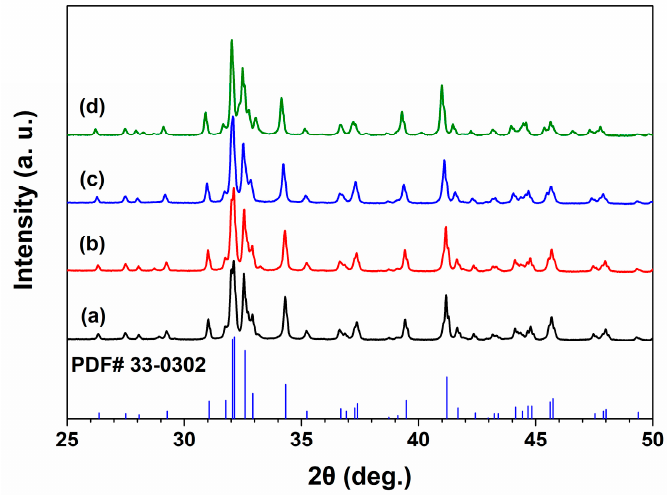
Figure 1. XRD patterns of C2S and Sr-C2S powders: ( a ) C2S; ( b ) Sr1-C2S; ( c ) Sr5-C2S; ( d ) Sr10-C2S. The XRD patterns of C2S and Sr-C2S powders are consistent with that of C2S standard diffraction data (PDF# 33-0302) . Table 3. 2 θ (deg.) values for ( − 1, 2, 1), (3, 0, 1) and (1, 3, 0) crystallographic plane of C2S and Sr-C2S.